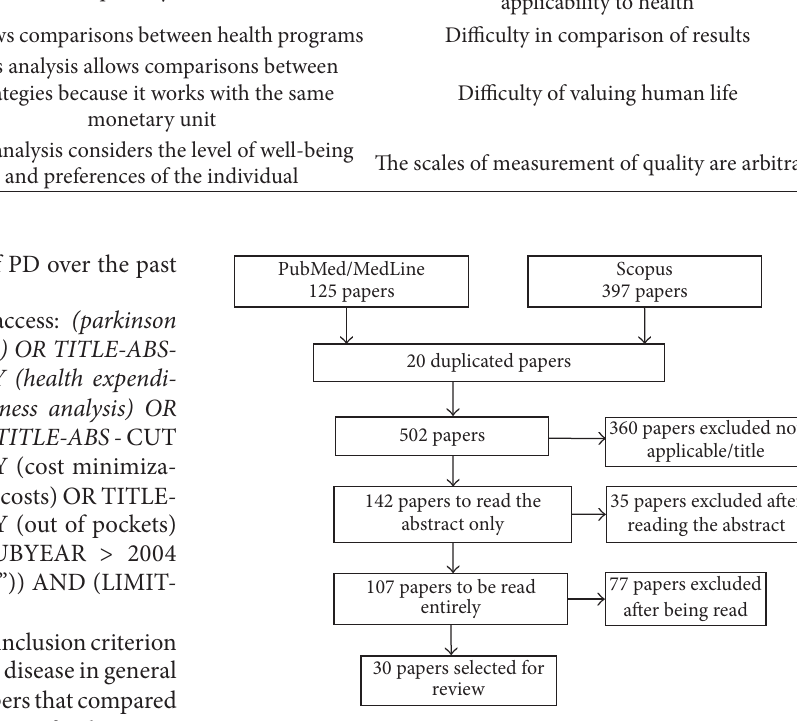
Figure 1: Search, selection, and inclusion of papers for critical analysis of studies on economic PD evaluation in online